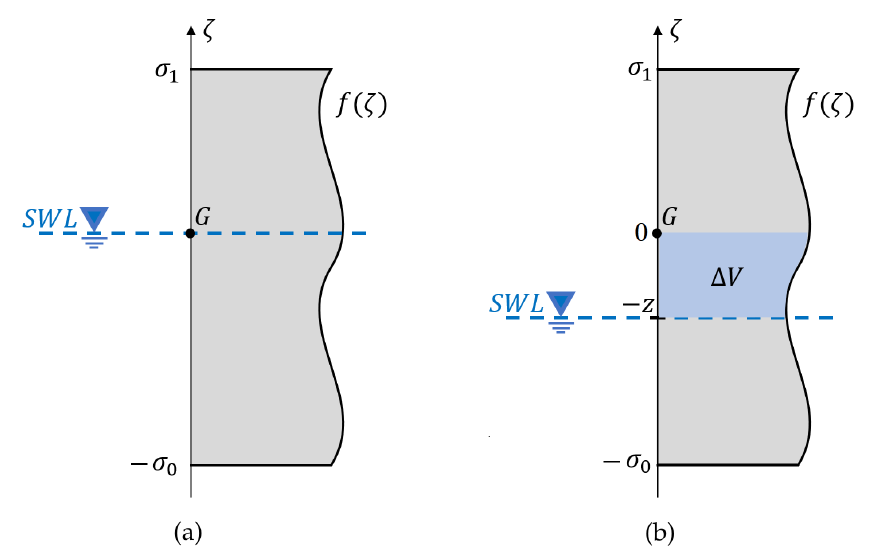
Figure 2. ( a ) The buoy shape for a generic f ( ζ ) function; ( b ) displaced